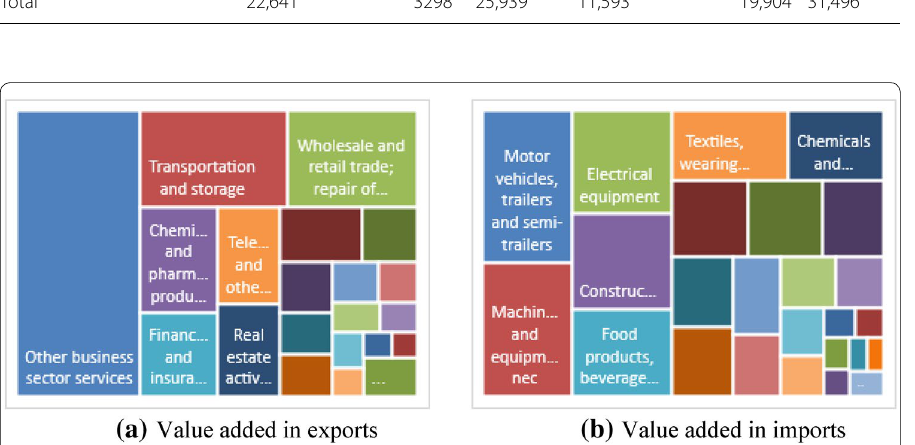
Fig. 5 Value added in international trade, Bogota industries, 2012